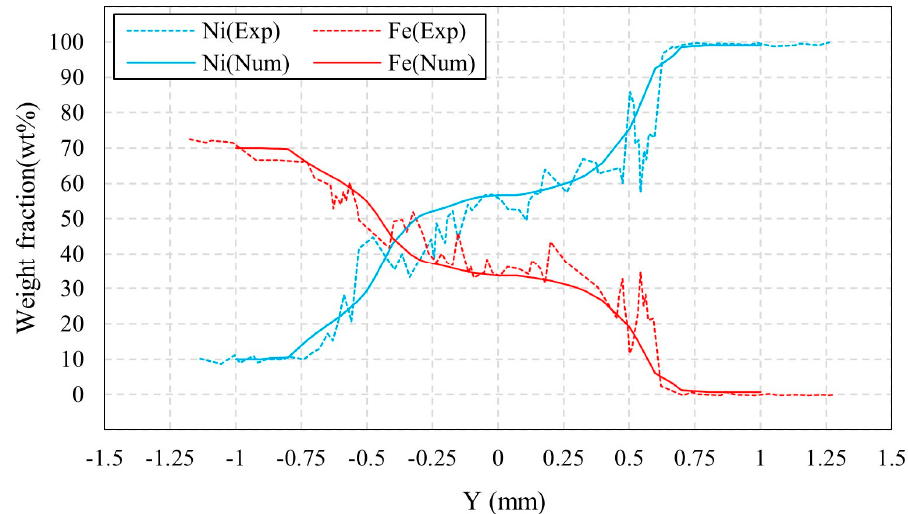
Figure 15. Comparison between simulated and experimentally measured [7] concentration distributions. Parameters: laser radius of 0.57 mm, welding speed of 30 mm/s, and laser power of 800 W.